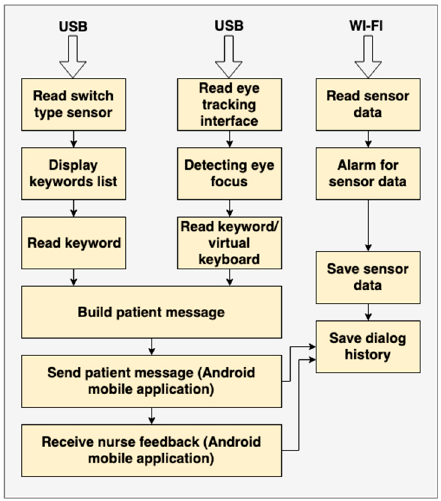
Figure 13. Overview of tasks for each device.